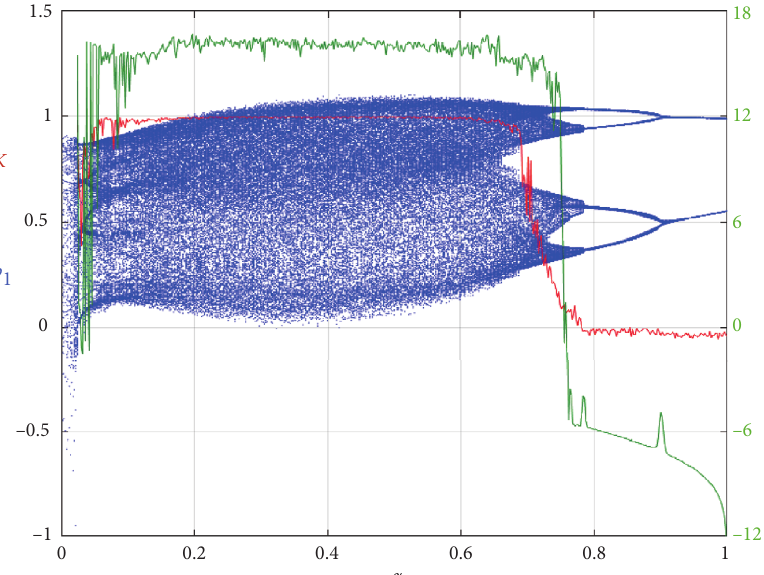
Figure 2: Firm 1’s price diagrams of bifurcation ( p correlation coefficient ( K , red) in system (14) with varying α ∈ ( 0 , 1 )